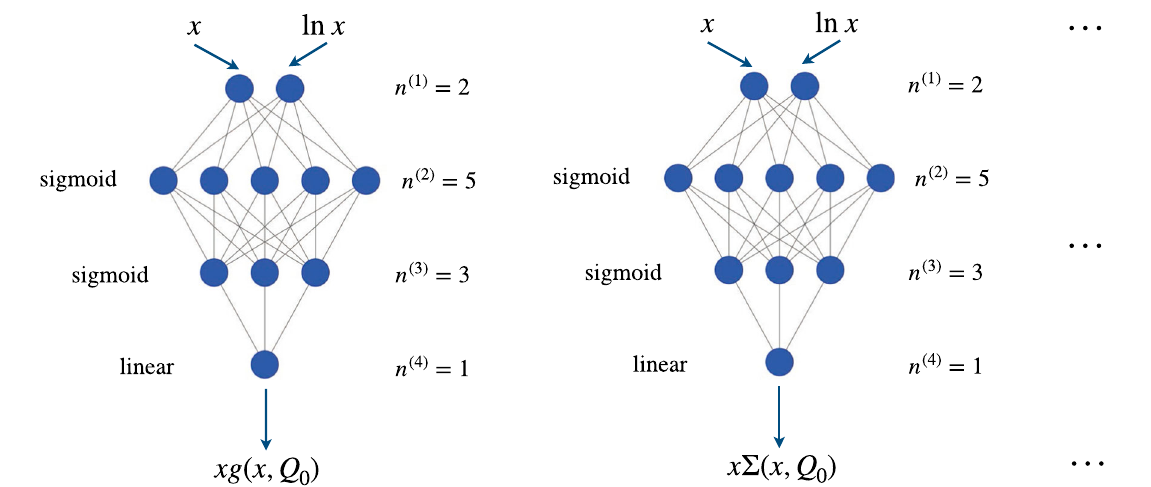
Fig. 10 The neural network architecture adopted in all previous NNPDF determinations up to NNPDF3.1. Each independent PDF combination is parametrized by a separate neural network, all sharing a common architecture Fig. 11 The neural network architecture adopted for NNPDF4.0. A single network is used, whose eight output values are the PDFs in the evolution (red) or the flavor basis (blue box). The architecture displayed corresponds to the optimal choice in the evolution basis; the optimal architecture in the flavor basis is different as indicated